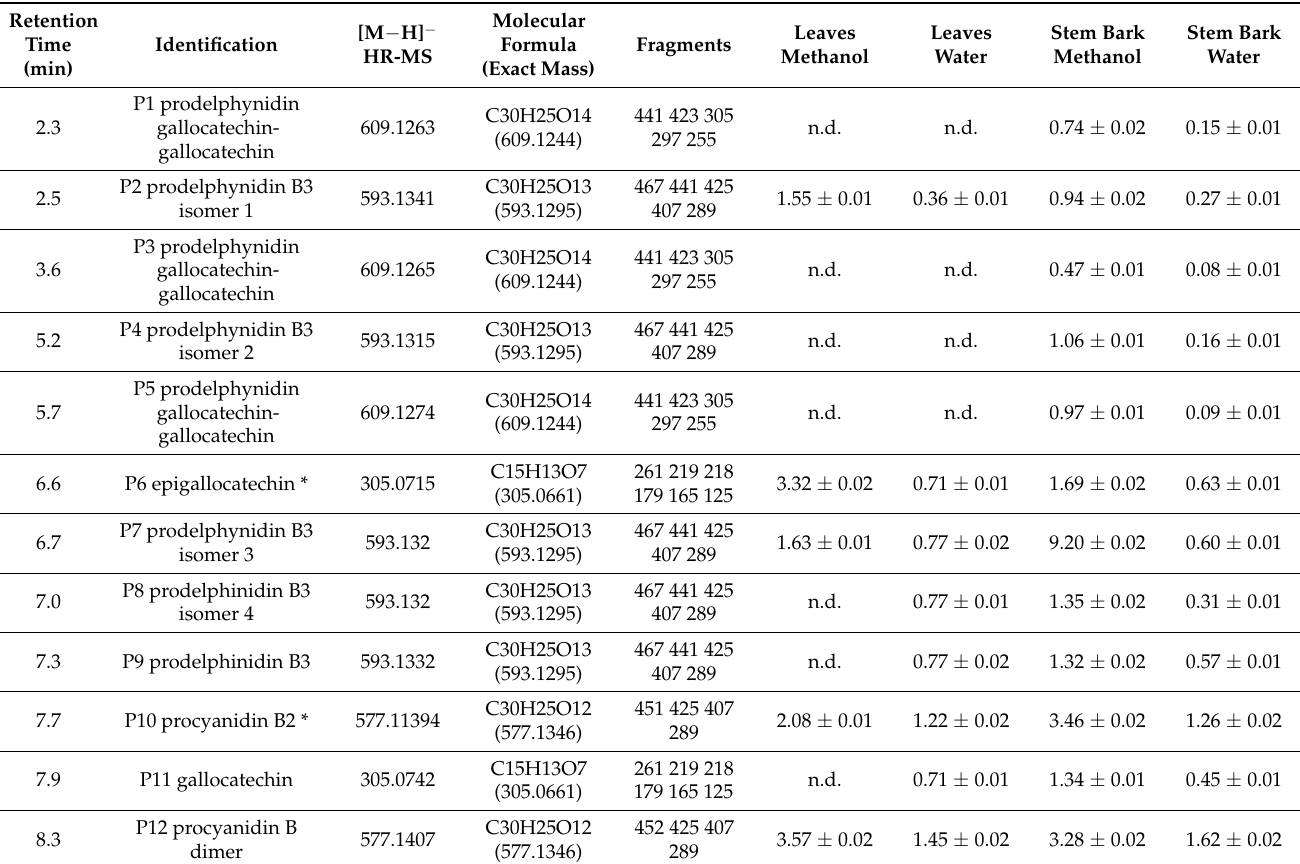
Table 3. Identified and quantified constituents of P. kotschyi leaves and stem bark extracts using LC-DAD-MS n (mg/g), * indicate confirmed identification by reference compound comparison. Number indicating compounds are the one used for the structure of the main compounds reported in Chart 1 and of LC-MS chromatograms of Chart 2. Retention